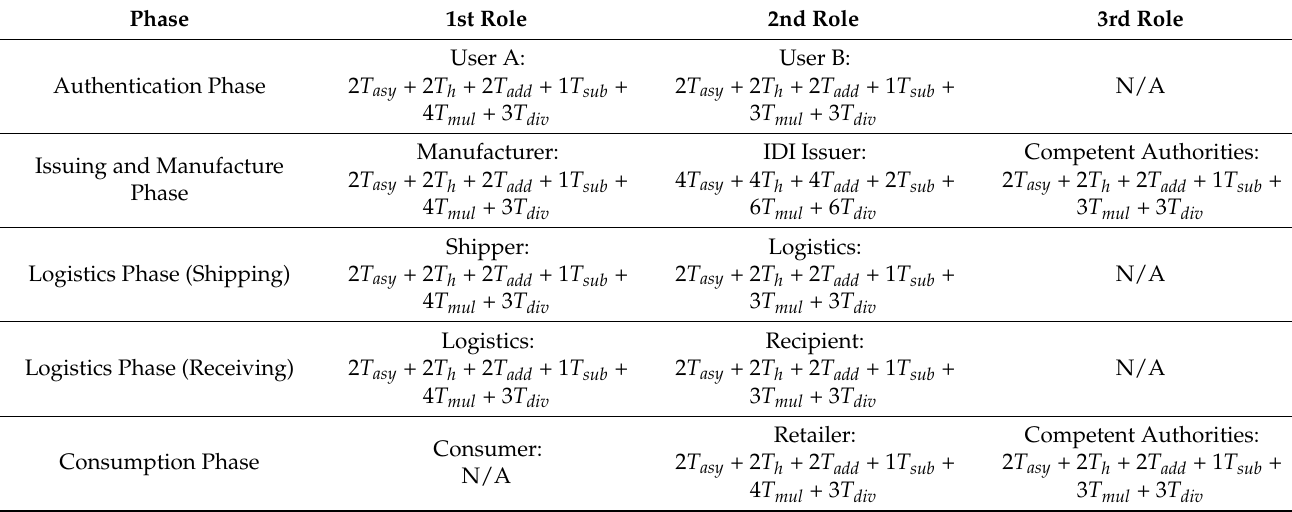
Table 4. Computation costs of the proposed